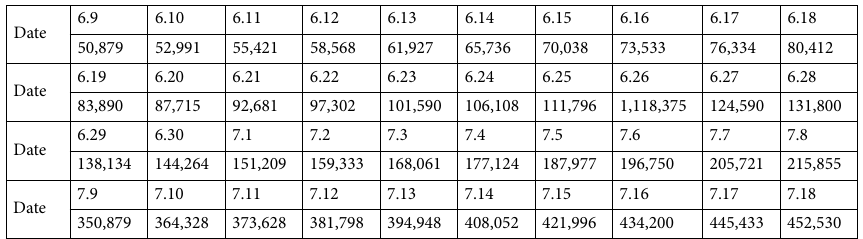
Table 2. Training set data.